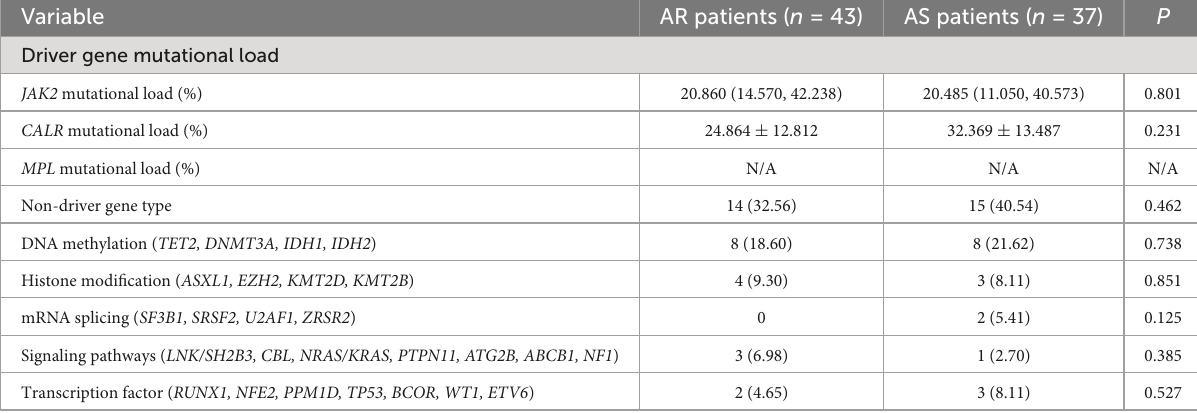
TABLE 6 Comparison of driver genes mutational load and non-driver genes types between AR and AS patients. Variable AR patients ( n = 43) AS patients ( n =